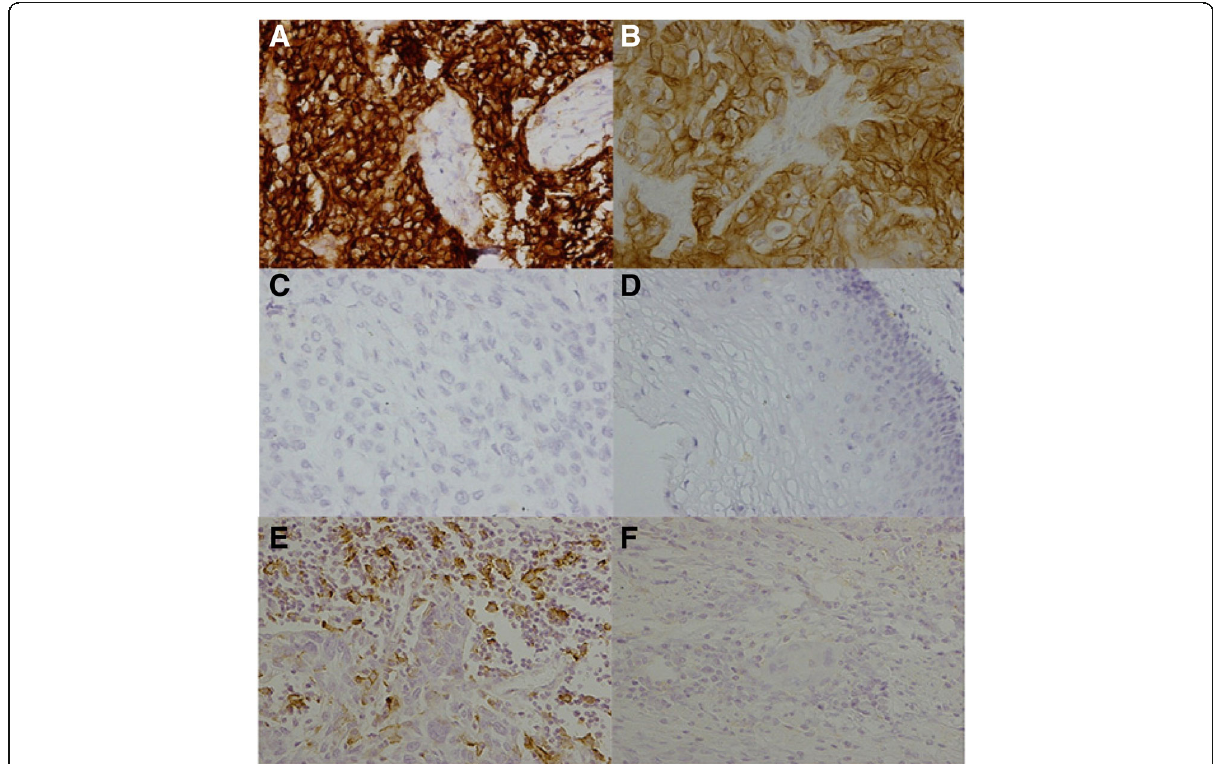
Fig. 1 PD-L1 expression in esophageal squamous cell carcinoma (ESCC) and adjacent non-malignant epithelium by immunohistochemistry staining. a Strong positive expression of PD-L1 in tumor cells. Original magnification, 400×. b Weak positive expression of PD-L1 in tumor cells. Original magnification, 400×. c Negative expression of PD-L1 in tumor cells. Original magnification, 400×. d The adjacent non-malignant epithelium. Original magnification, 200×. e Positive expression of PD-L1 in tumor-infiltrating immune cells. Original magnification, 400×. f Negative expression of PD-L1 in tumor-infiltrating immune cells. Original magnification,